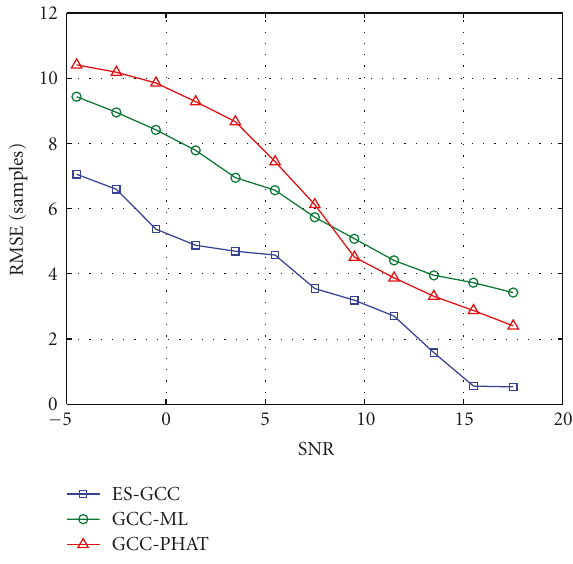
Figure 8: TDE RMSE results versus SNR.